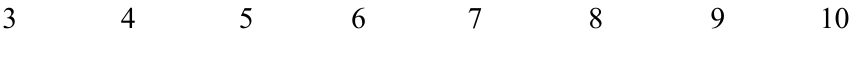
Table 2 Descriptive Statistics: Means, Standard Deviations, Correlations and Discriminant Validity of the constructs